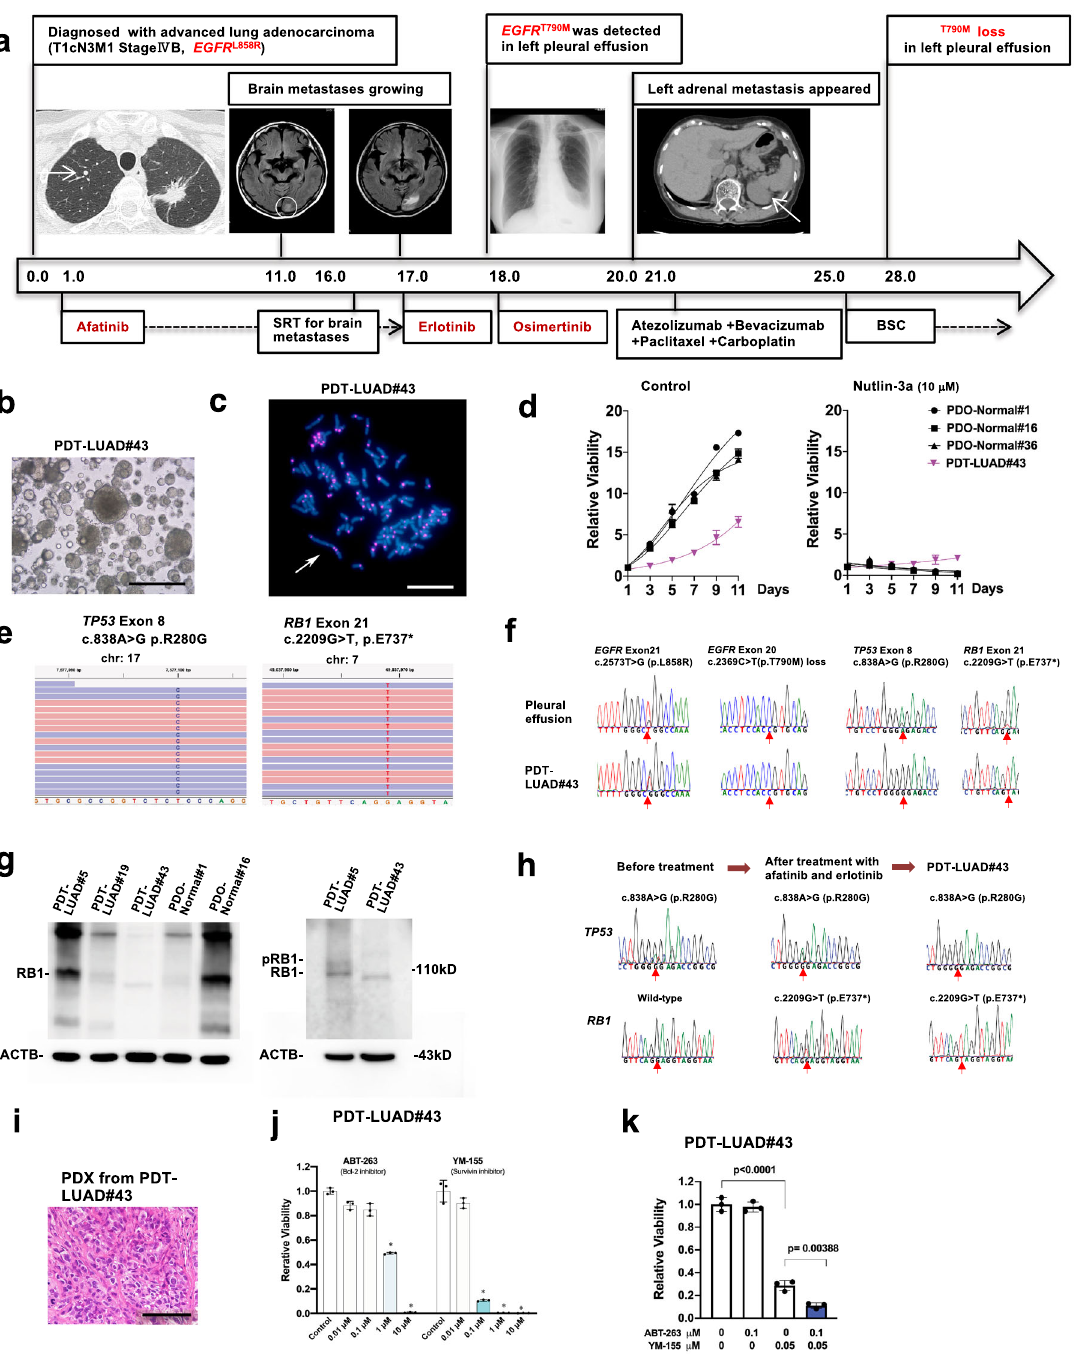
Fig. 3 Patient-derived tumoroids (PDTs) from malignant effusion of lung cancer with acquired resistance to EGFR TKIs (tyrosine kinase inhibitors) (PDT-LUAD#43). a Timeline of treatment for a patient with EGFR mutations is shown. Numbers represent months since initial diagnosis. b Shown is a bright- fi eld microscopy image of PDT-LUAD#43. Scale bar, 500 μ m. c Metaphase FISH image is shown as described in Fig. 1e. Aberrant chromosome indicated by a white arrow was seen. Scale bar, 20 μ m. d Cell viability assays were conducted as described in Fig. 1d. e Exome-seq detected c.838A > G (p.R280G) in both alleles of TP53 and c.2209G > T (p.E737*) in both alleles of RB1 from PDT- LUAD#43. Red and blue lines represent forward and reverse reads, respectively. f Sanger sequencing detected monoallelic EGFR c.2573T > G (p.L858R) alteration in addition to the exome-seq data shown in Fig. 3e. EGFR c.2369C > T (p.T790M) mutation was detected before osimertinib treatment but was lost in the effusion and the tumoroid. g Total RB1 was detected using RB1 antibody in all lung tumoroids (PDTs) and normal lung organoids (PDOs) except PDT-LUAD#43 (left panel). A phosphorylated RB1 band in PDT-LUAD#5 but not in PDT-LUAD#43 was observed using a longer running gel (right panel). h Sanger sequencing detected TP53 c.838A > G (p.R280G) mutation in the biopsied specimen before any of the TKI treatment. RB1 c.2209G > T (p.E737*) mutation was not detected before the TKI treatment, however the mutation appeared after afatinib and erlotinib treatment. i Shown is an HE stained image of PDX derived from PDT-LUAD#43. Scale bar, 100 μ m. j Bcl-2 inhibitors (ABT- 263) and a survivin inhibitor (YM-155) signi fi cantly suppressed the growth of PDT-LUAD#43 72 h after treatment. Cell viability assays were performed as described in Fig. 1d. Data are shown as mean ± SD. k Combination treatment of ABT-263 and YM-155 signi fi cantly suppressed the viability of PDT-LUAD#43 72 h after treatment. Data are shown as mean ±